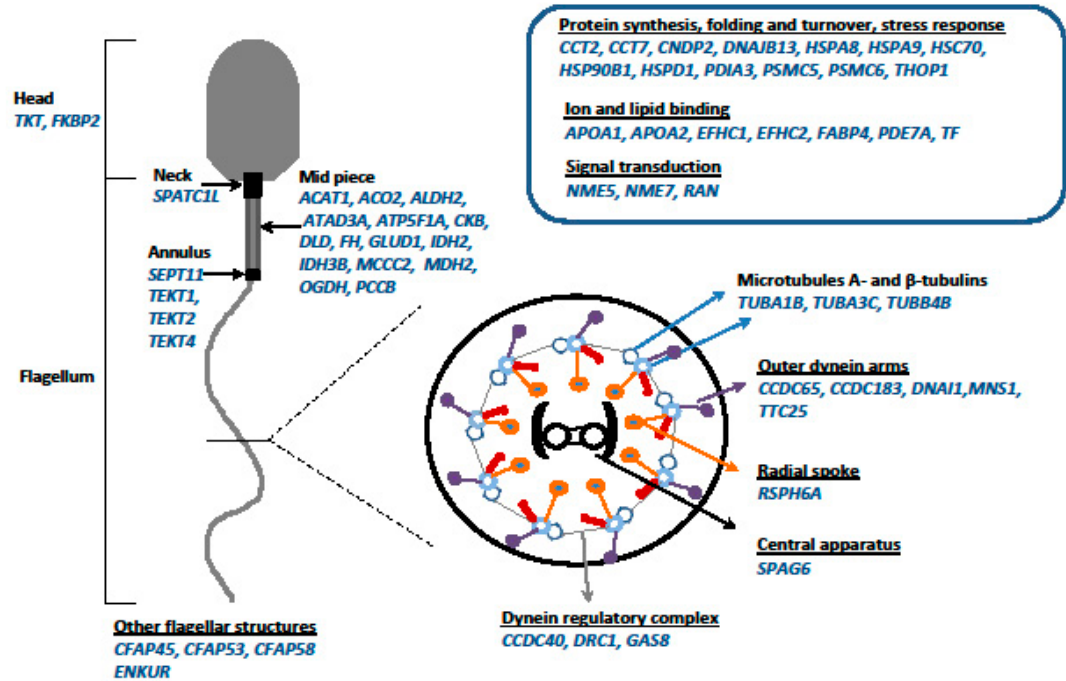
Figure 4. Changes in the sex-reversed female (SRF) rainbow trout proteome after in vitro incubation in artificial seminal plasma (ASP).